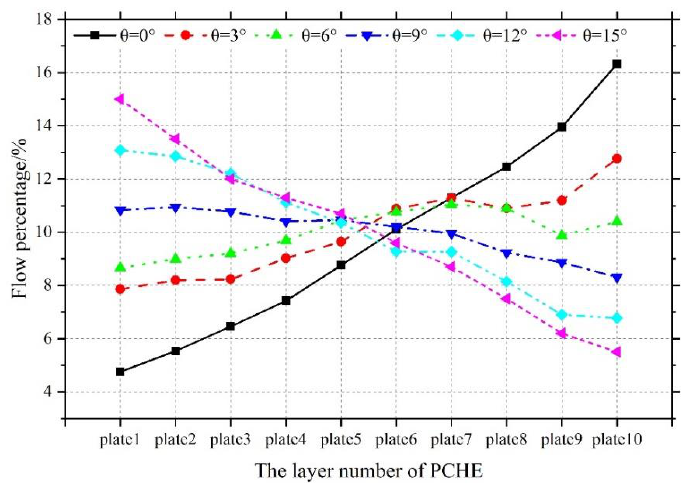
Figure 9. Flow distribution uniformity ratio of each layer.